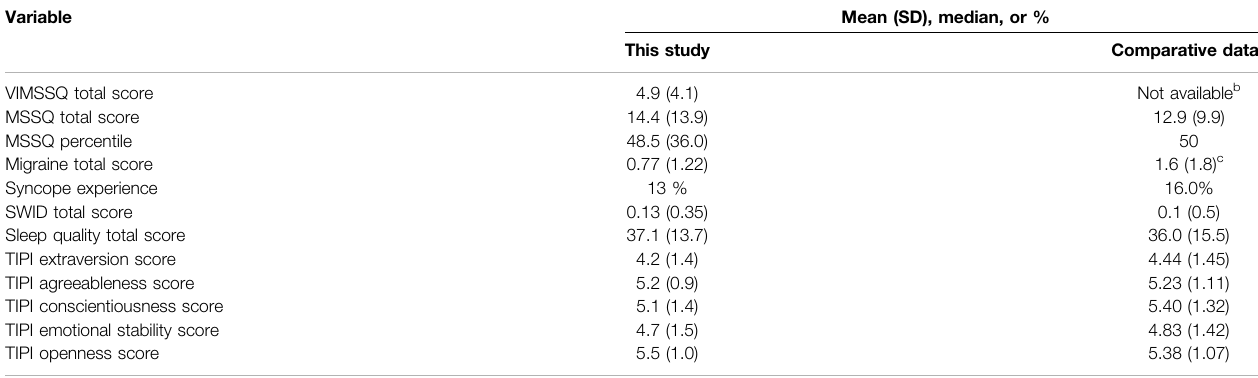
TABLE 2 | Baseline questionnaires: descriptive data. Variable